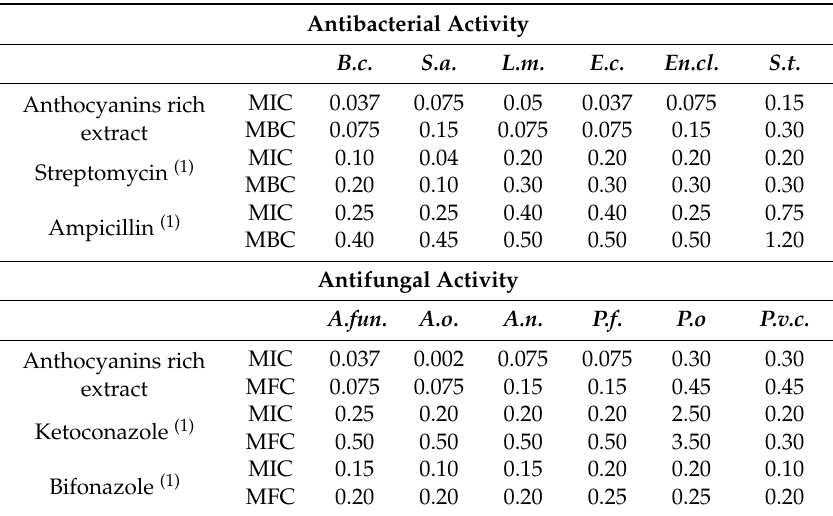
Table 7. Antibacterial activity (MIC and MBC, mg/mL) and antifungal activity (MIC and MFC, mg/mL) of the anthocyanins rich extract obtained under optimal extraction